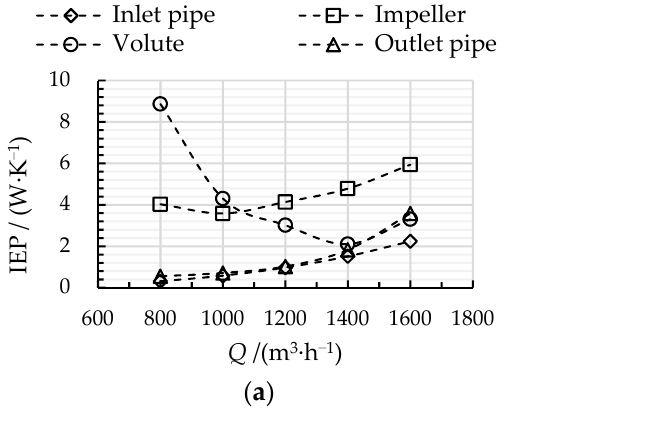
Figure 8. The distribution of ( a ) IEP and ( b ) DEP in the mixed-flow pump with a volute .